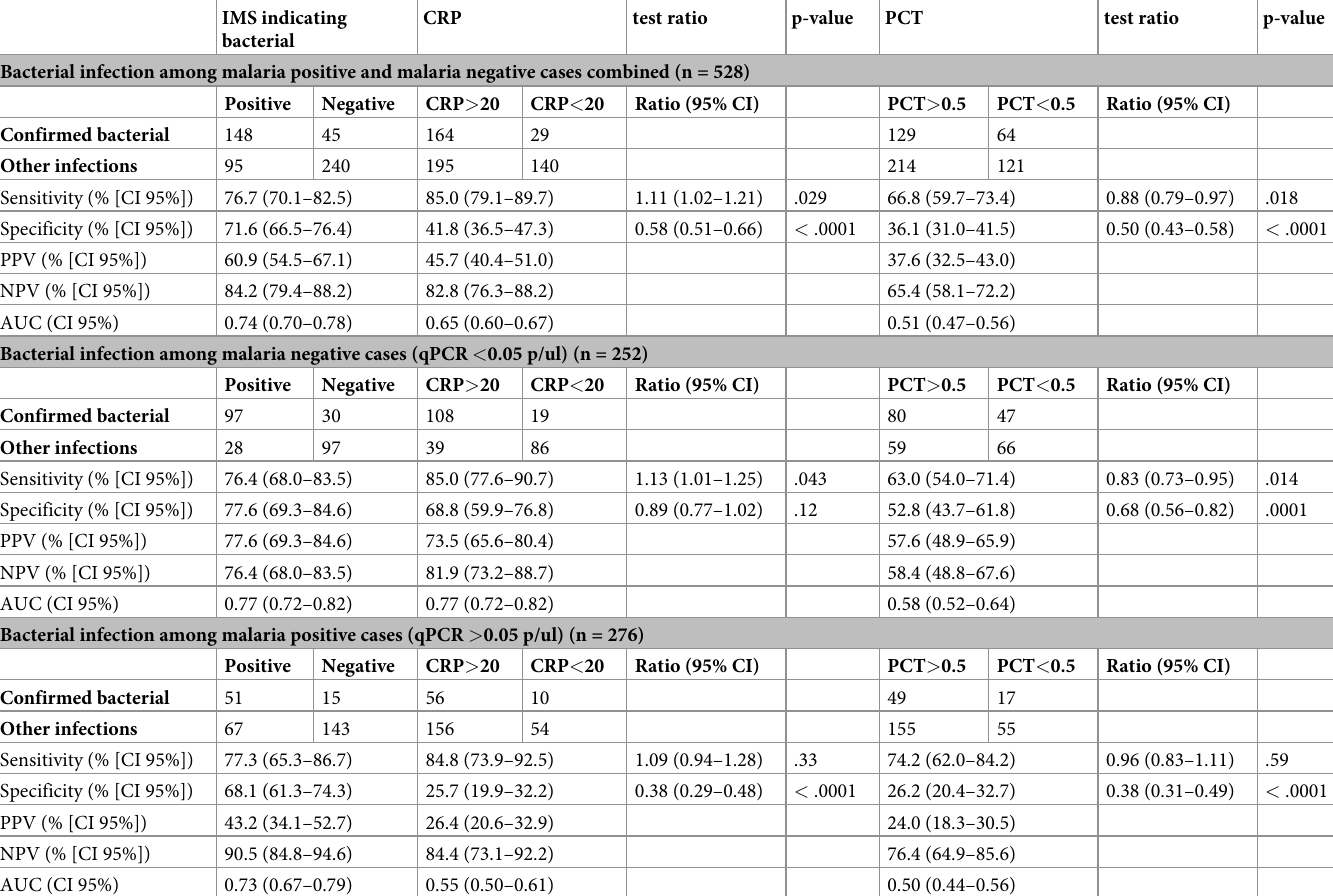
Table 7. Diagnostic accuracy of the IMS to detect all bacterial infections versus standard microbiological techniques among patients of all ages, presented for malaria positive cases, malaria negative cases and all cases, and compared to accuracy of CRP and PCT. IMS indicating